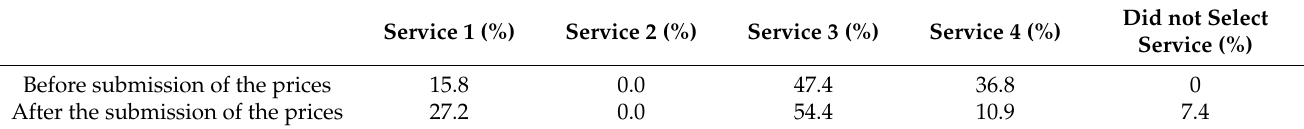
Table 4. Choice of service before and after disclosure of respective prices to